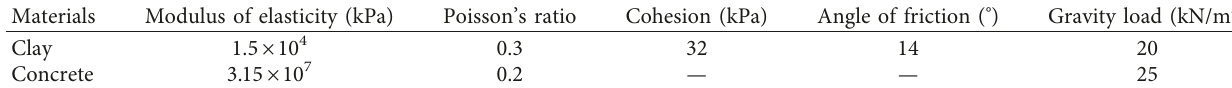
Table 1: Material parameters of the numerical